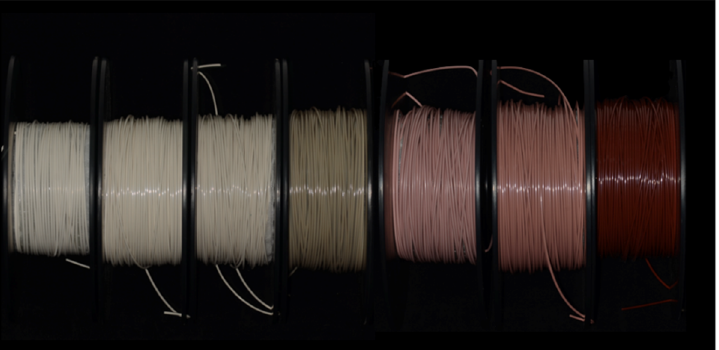
Figure 6. A series of dual-color PEEK filaments. From left to right : PEEK filaments with tooth-like colors (PEEK D1, D2, D3), pure PEEK filaments for contrast, and PEEK filaments with gingiva-like colors (PEEK G1, G2, G3).